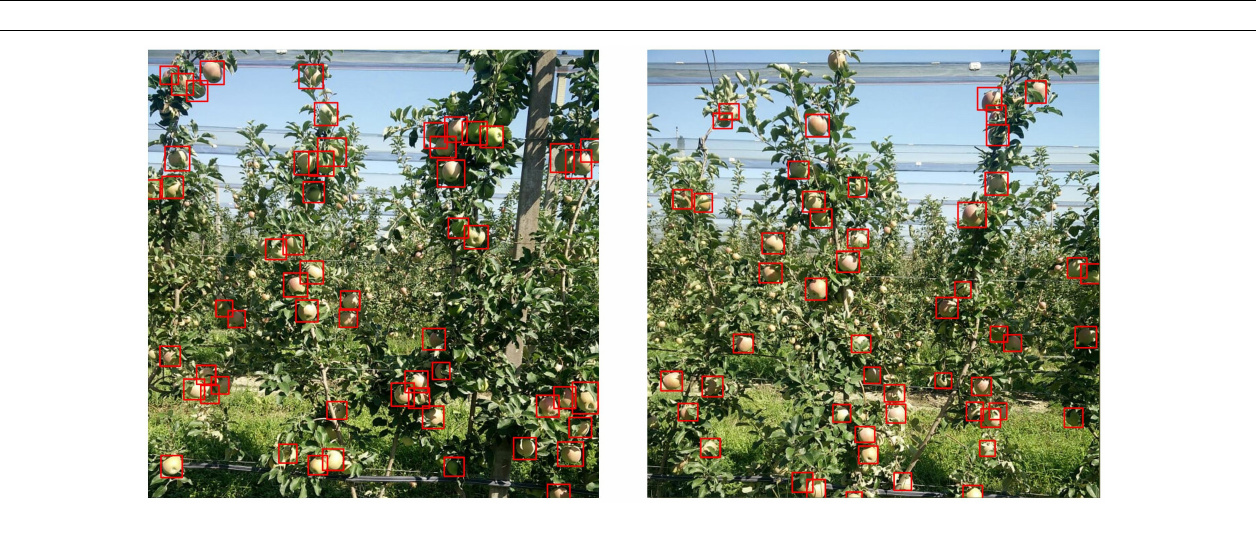
FIGURE 3 | Input image augmentation. (A) Augmenting from an image to four. (B) Synthetic generated image.